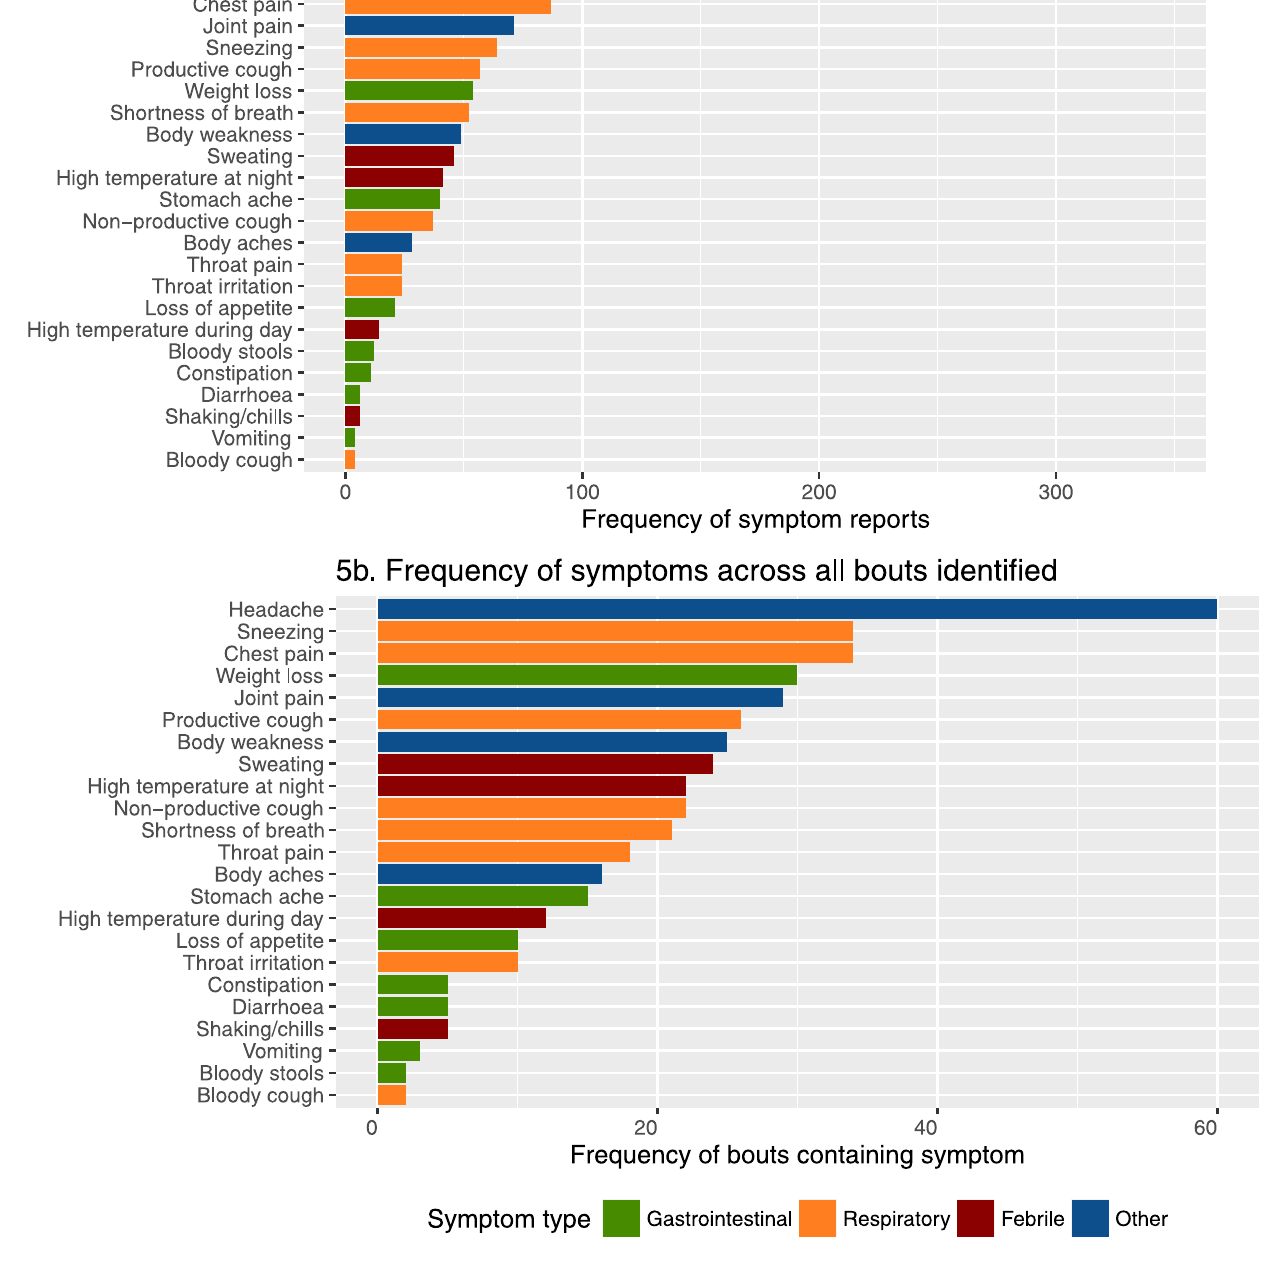
Fig 5. Number of mentions of each symptom across all reports, coloured by symptom type (5a). Frequency of distinct bouts containing at least one mention of a given symptom ( 5b ).